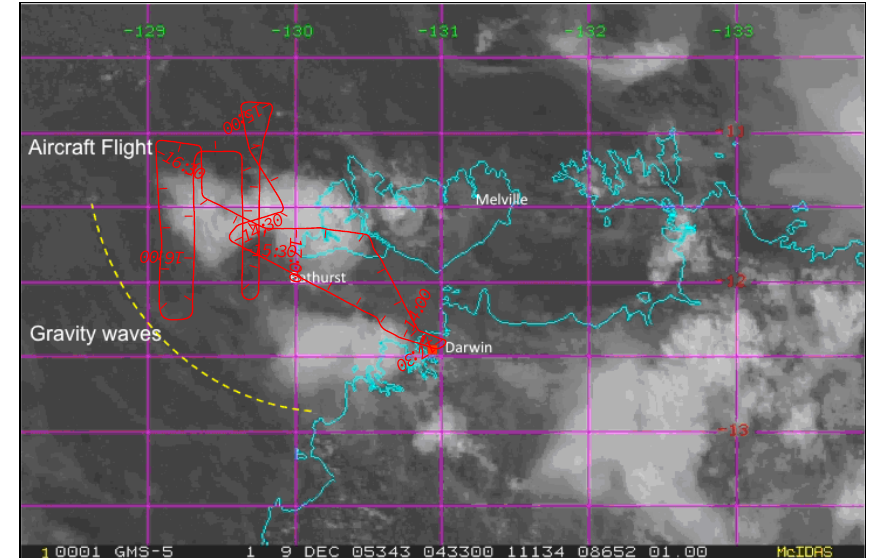
Fig. 2. MTSAT 1R image showing a Hector storm developing, north of Darwin and the Ci outflow for the ACTIVE case study of AE13 on 2005/12/09 from 03:33–06:16UTC. Melville and Bathurst islands are highlighted and the flight track of the Egrett (with times) is shown in red. Also visible from the satellite image were gravity waves propagating out from the convective region (highlighted in yellow). These gravity waves are not the subject of this